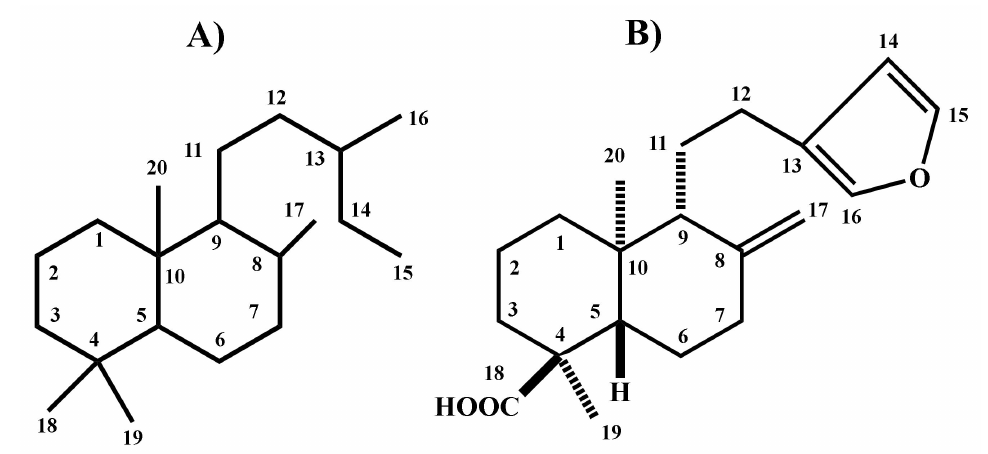
Figure 1. Representation of the following structures: ( A ) labdane-type diterpenes and ( B ) polyalthic